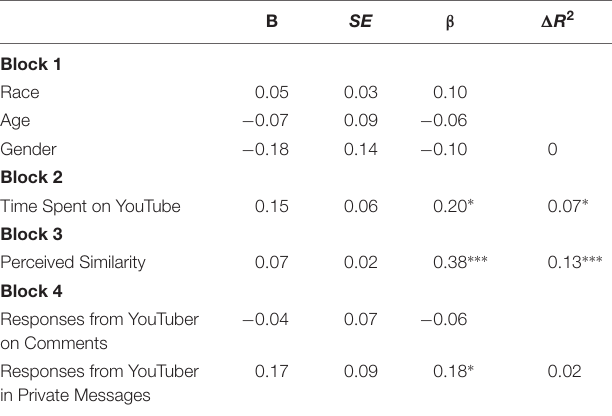
TABLE 8 | Summary of hierarchical regression for interpersonal interaction with YouTuber predicting parasocial